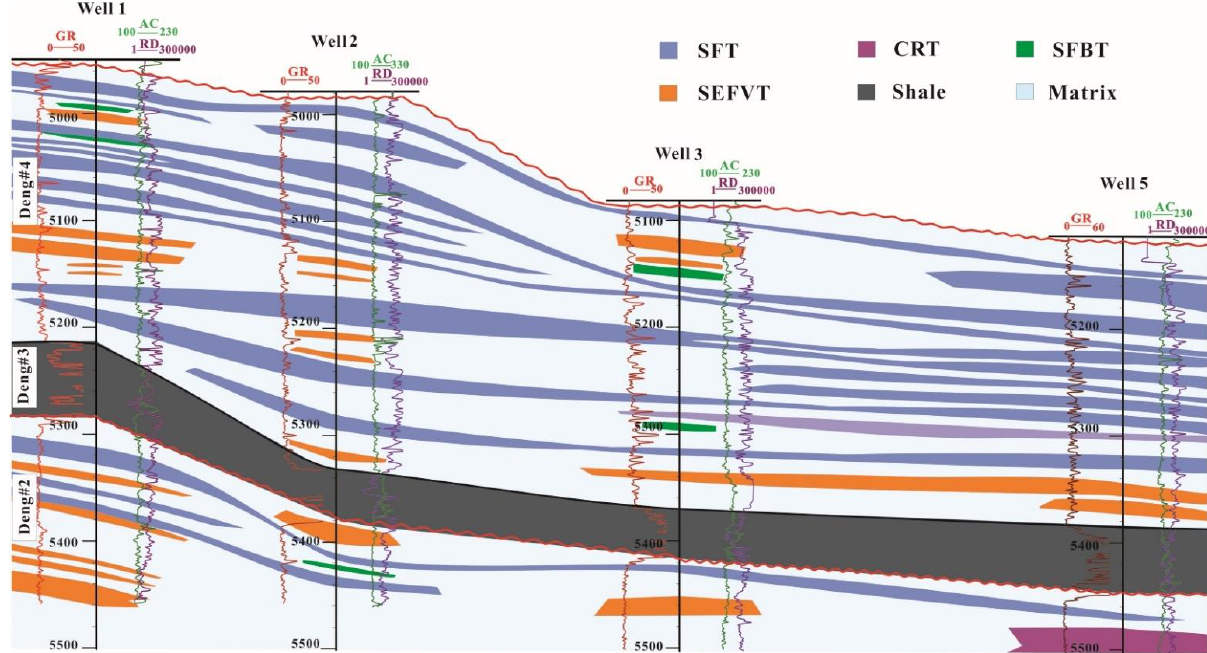
Figure 11. Vertical distribution of void space types in a cross-section in the MG block. (SFT: solution-filling type; CRT: cement-reducing type; SFBT: solution-filling breccia type; SEFVT: solution-enlarging fractures and vugs type).